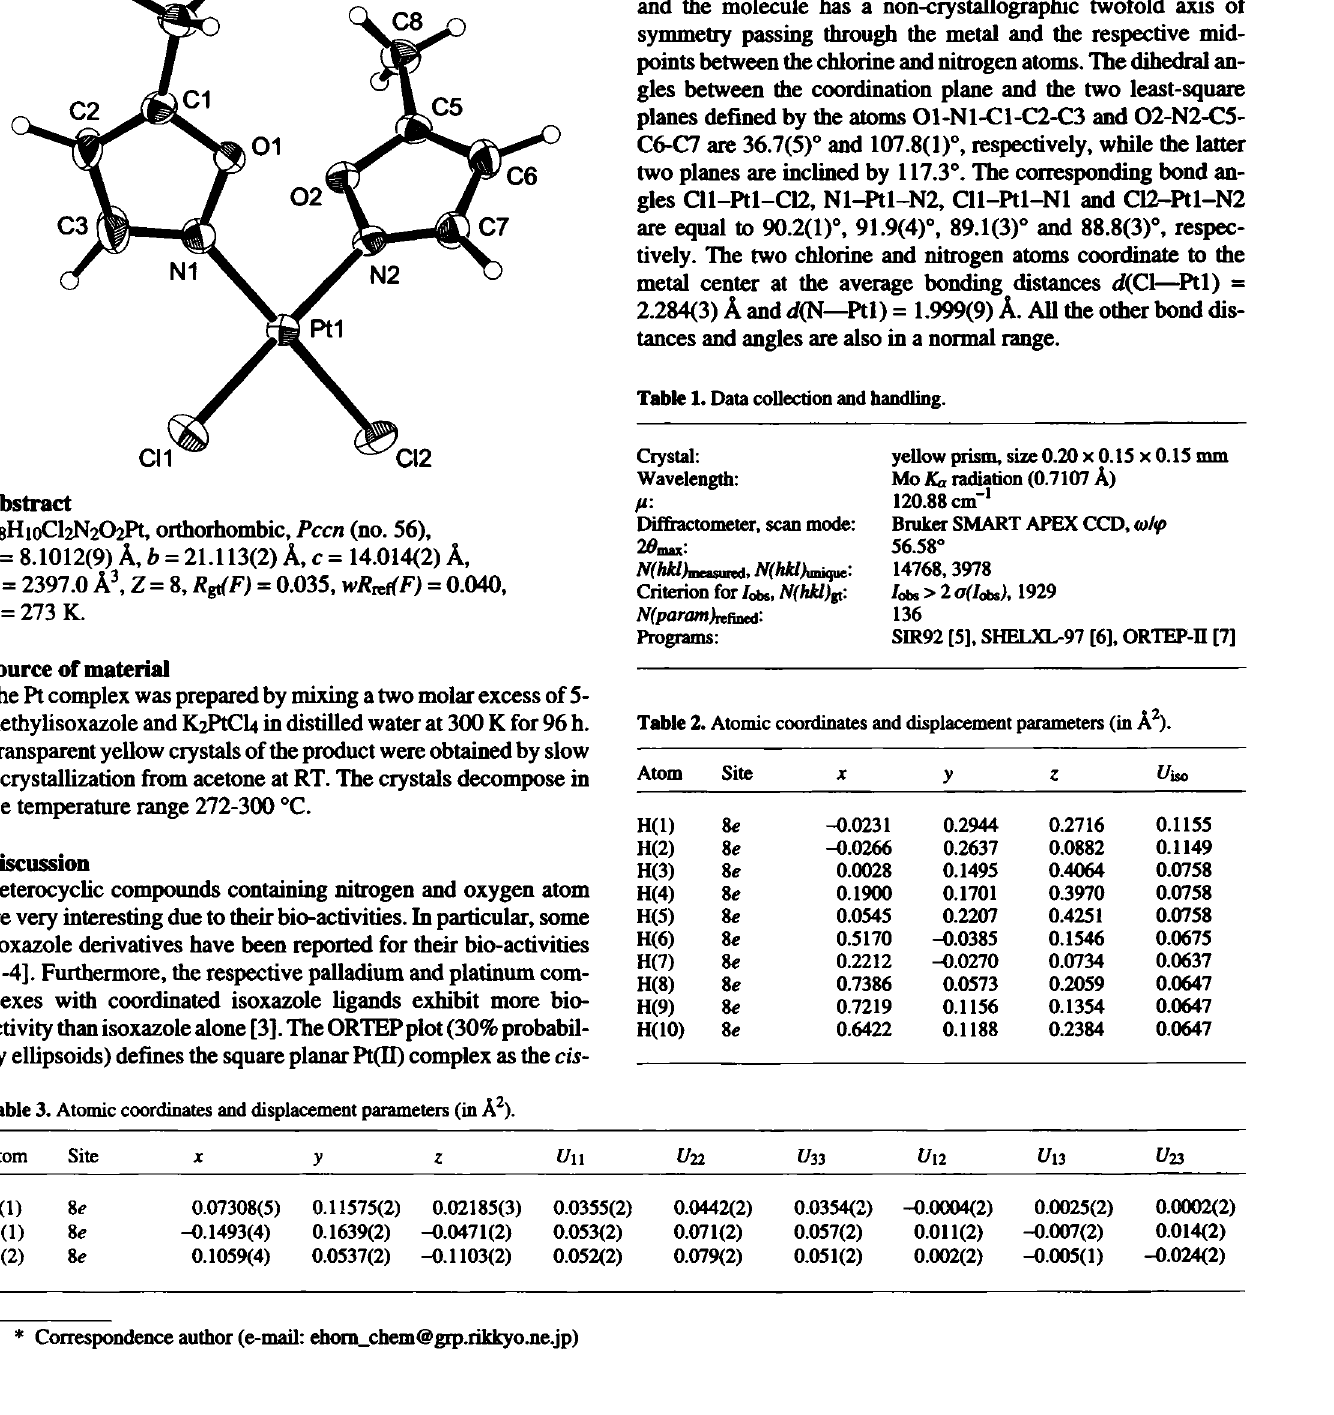
Table 2. Atomic coordinates and displacement parameters (in A 2